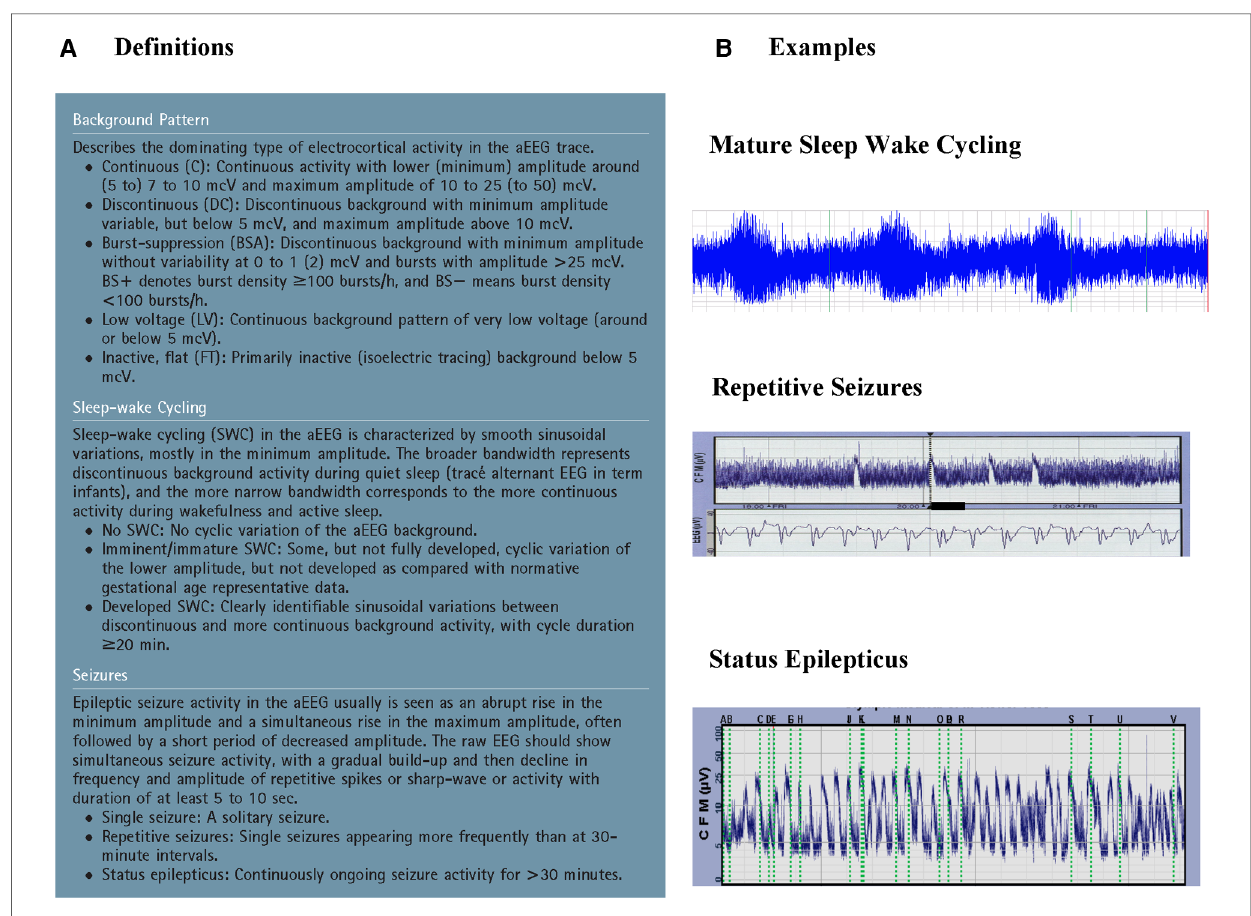
FIGURE 2 A: Suggested classi fi cation of aEEG patterns in preterm and term infants (reproduced with permission from hellström-westas L, rosén I, de Vries L, greisen G. Amplitude-integrated EEG classi fi cation and interpretation in preterm and term infants. Neoreviews. 2006;7(2):376-e86) and B: Examples of sleep- wake cycling, repetitive seizures, and status